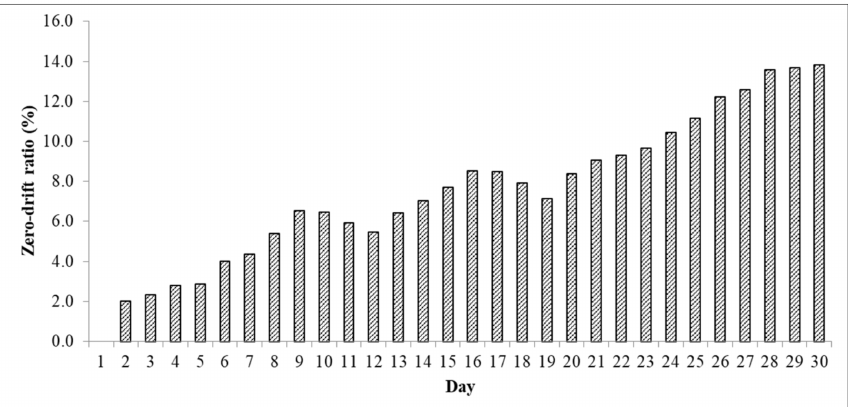
Figure 10. Zero-drift of the NDIR analyzer coupled with the typical reference channel for 30 days with respect to IR source aging.